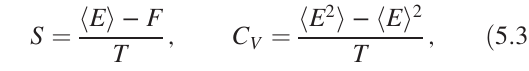
FIG. 5. Thermodynamic properties of the many-body Hamil- tonian Eq. (2.15). (a) Thermal entropy per particle and (b) heat capacity per particle. Dashed lines show the expected behavior for the SYK model with random independent couplings, solid lines show results for the couplings obtained from the giant vortex system. In all panels the same parameters are used as in Fig. 4 with V 0 adjusted so that J ¼ 1